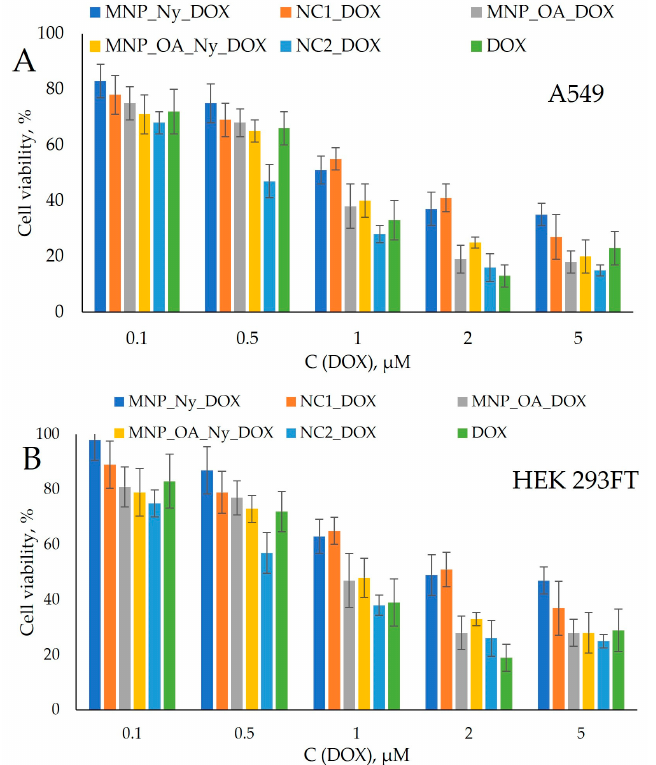
Figure 8. Cell viability assay. Cell lines A549 ( A ) and HEK 293FT ( B ) were incubated for 48 h with MNP_Ny_DOX, NC1_DOX, MNP_OA_DOX, MNP_OA_Ny_DOX, NC2_DOX, and DOX. Cells treated with PBS bu ff er were used as a 100% viability control. All values are given as mean ± standard deviation (SD) values. All measurements were repeated no fewer than three times.